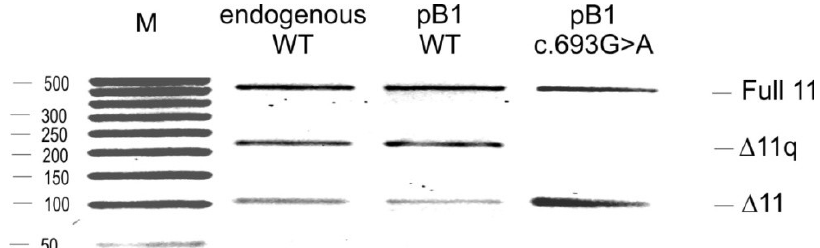
Figure 2. Analysis of BRCA1 minigene. Reverse transcriptase PCR (RT-PCR) (as in Figure 1) from the transfection of endogenous BRCA1 (endogenous wild-type (WT)), the minigene wild-type (pB1WT) and the minigene with the variation (pB1 c.693G>A). To the right of the gel is reported the isoform corresponding to each of the three bands: full-length 11 (Full 11), Δ11, Δ11q isoforms. M—ladder.